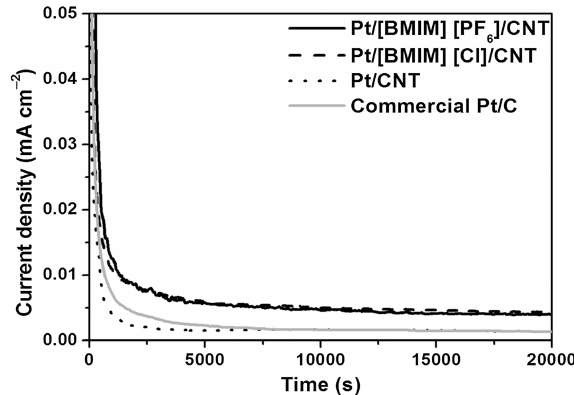
Figure 4. Chronoamperometric curves of Pt/[BMIM][PF 6 ]/CNT, Pt/[BMIM][Cl]/CNT, Pt/CNT nanohybrids, and commercial Pt/C NPs electrodes at a fi xed potential of (cid:1) 0.1 V vs. Ag/AgCl in 0.5 M KOH containing 0.5 M